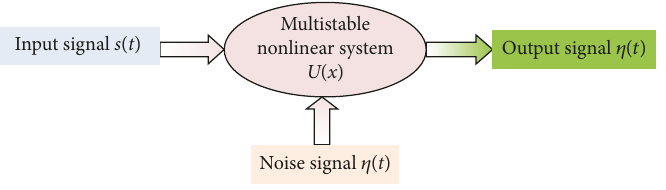
Figure 1: Multistable nonlinear system.